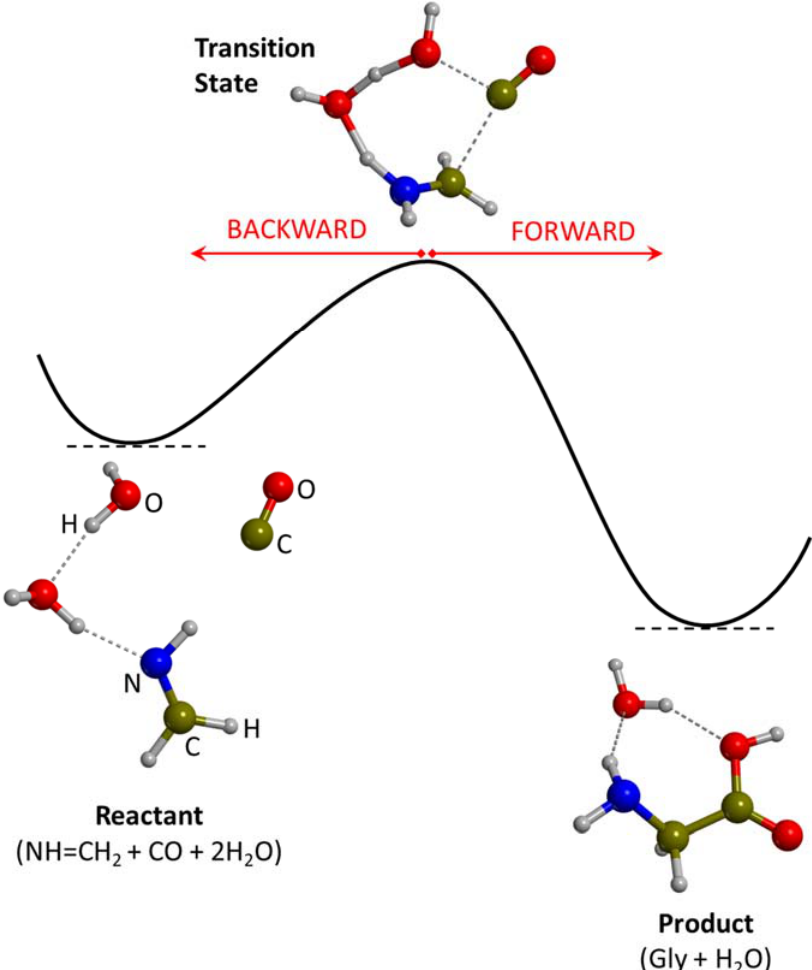
Figure 2. Schematic representation of the evolution towards the product (Gly + H 2 O) or the reactant (NH=CH 2 + CO + H 2 O) in AIMD trajectories executed from the transition state. Adapted from Ref. [142].